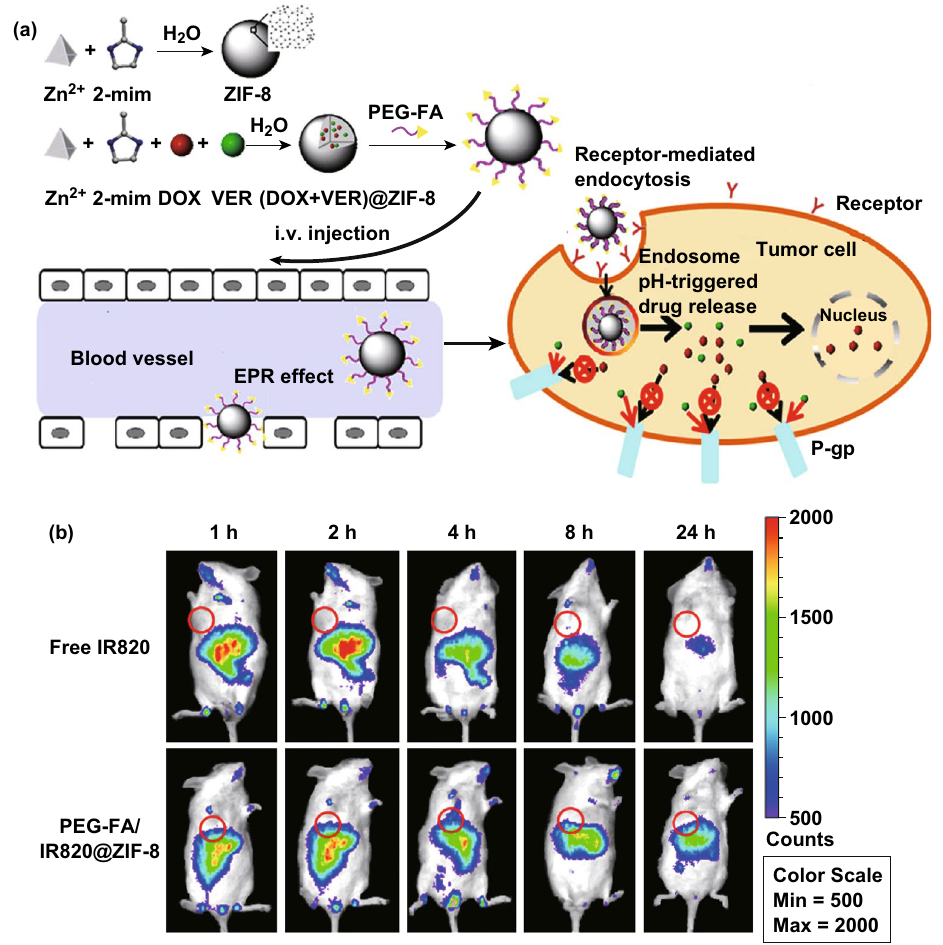
Fig. 7 a Schematic representation of pH-responsive ZIF-8 as a co-delivery system for overcoming MDR for efficient targeted cancer therapy: PEG-FA/(DOX + VER)@ZIF-8 synthesis; accumulation in tumors via EPR effect; internalization via FR-mediated endocytosis; pH-dependent drug release under weak acidic environments; VER-mediated MDR reversal. The biological ligand has been binded (physically touch the recep- tor) in order for receptor-mediated endocytosis to take place. b In vivo fluorescence imaging of B16F10 bearing mice at 1, 2, 4, 8, and 24 h after the injection of free IR820 or PEG-FA/IR820@ZIF-8. Reproduced with permission from Ref. [106]. Copyright 2017, American Chemical Soci-